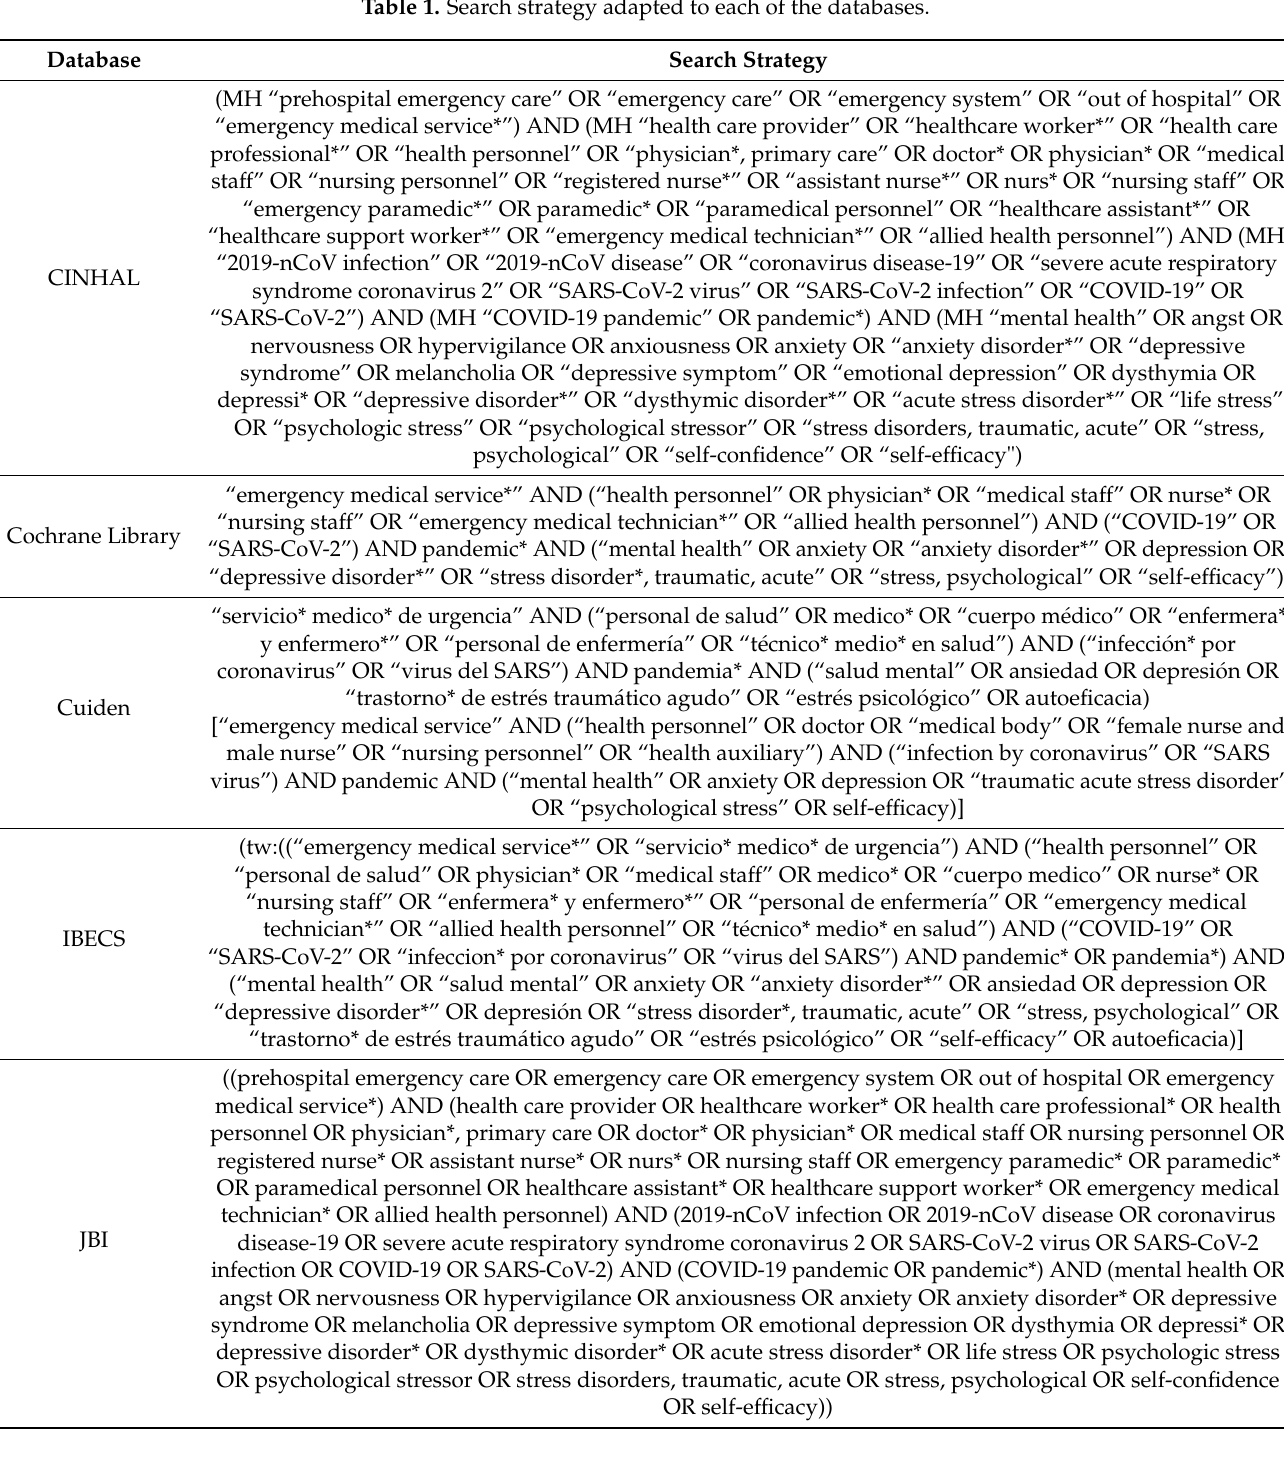
Table 1. Search strategy adapted to each of the